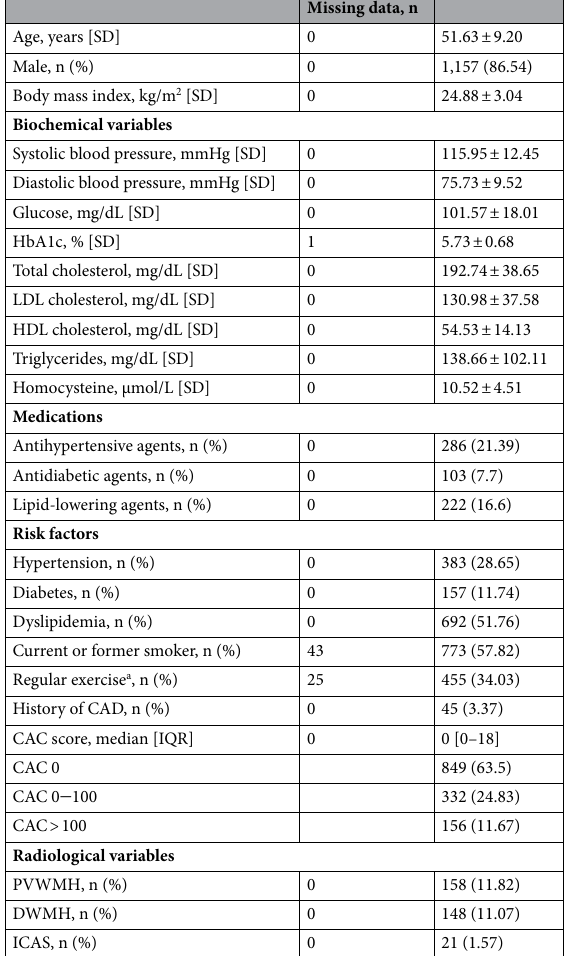
Table 1. Baseline characteristics of the study participants (n = 1337). PVWMH Periventricular white matter hyperintensity, DWMH Deep white matter hyperintensity, LDL Low-density lipoprotein, HDL High-density lipoprotein, HbA1c Glycohemoglobin, CAD Coronary artery disease, CAC Coronary artery calcium, ICAS Intracranial artery stenosis, SD Standard deviation, IQR Interquartile range. a Regular engagement in vigorous exercise for more than 10 min at least 3 times per